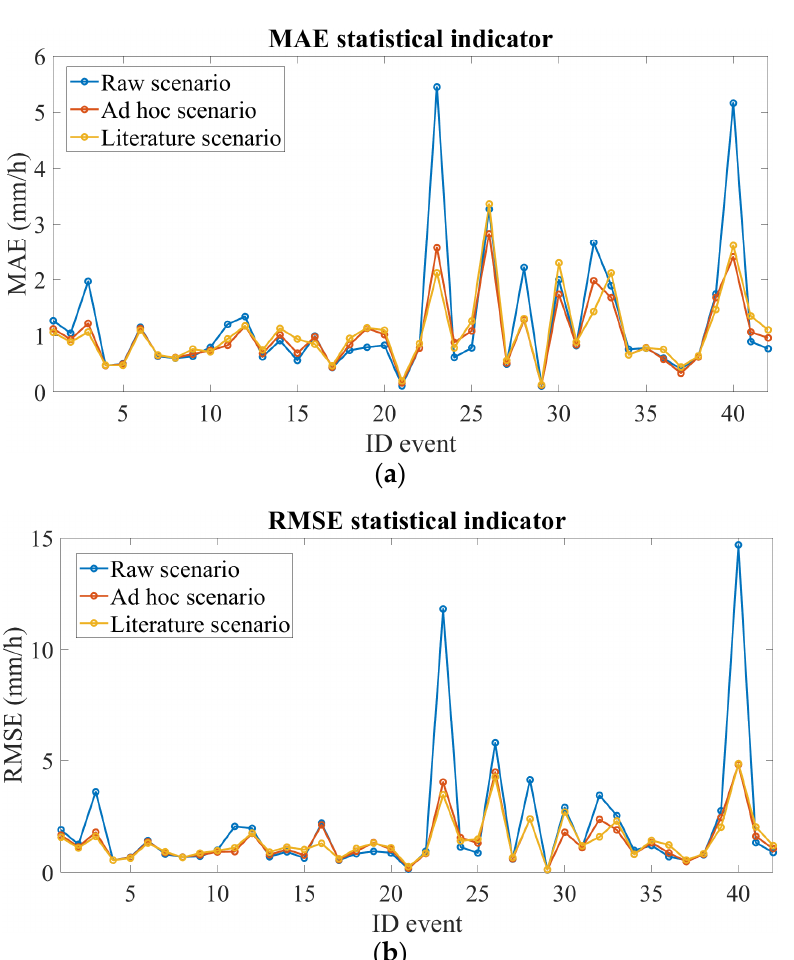
Figure 6. MAE ( a ) and RMSE ( b ) value for each of the 42 rainy events analyzed in study. Blue, red and orange lines show the results obtained for raw, ad hoc and literature disdrometric data, respectively. Both indicators are in (mm h − 1 ). Table 2. Rain gauge vs. disdrometer error statistical indicators of rain rate in terms of error per- centage (E), mean absolute error (MAE) and the root mean square error (RMSE), as defined by Equations (8), (6) and (9), respectively. The mean and standard deviation (Std) are listed for all scenarios. These results refer to the whole dataset.